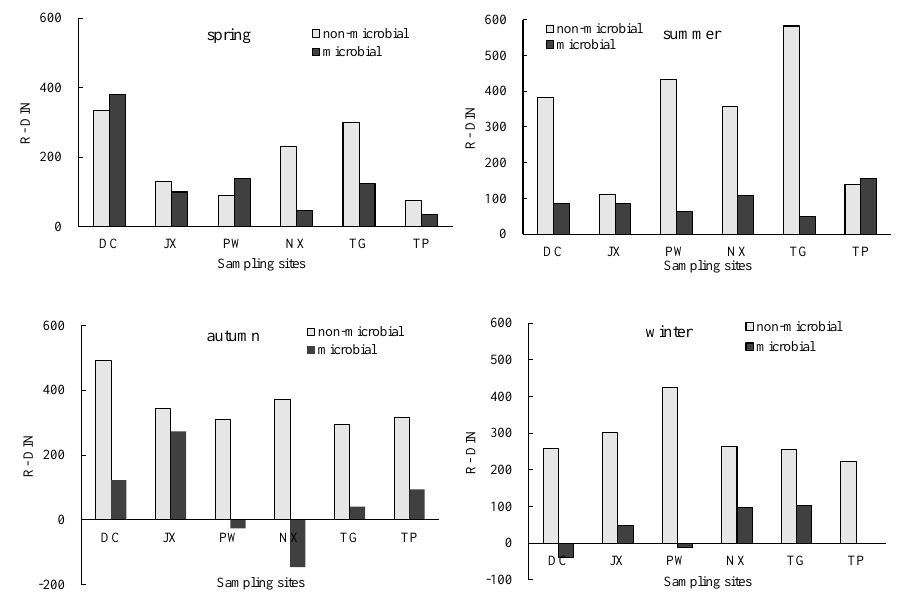
Figure 9. Microbial and non-microbial DIN (dissolved inorganic N) reduction rates at sampling sites in different seasons (mg·(m 3 ·d) −1 ). Table 2. Proportion of DIN (dissolved inorganic N) reduction rates and N load attributable to microbial and non-microbial processes (%).